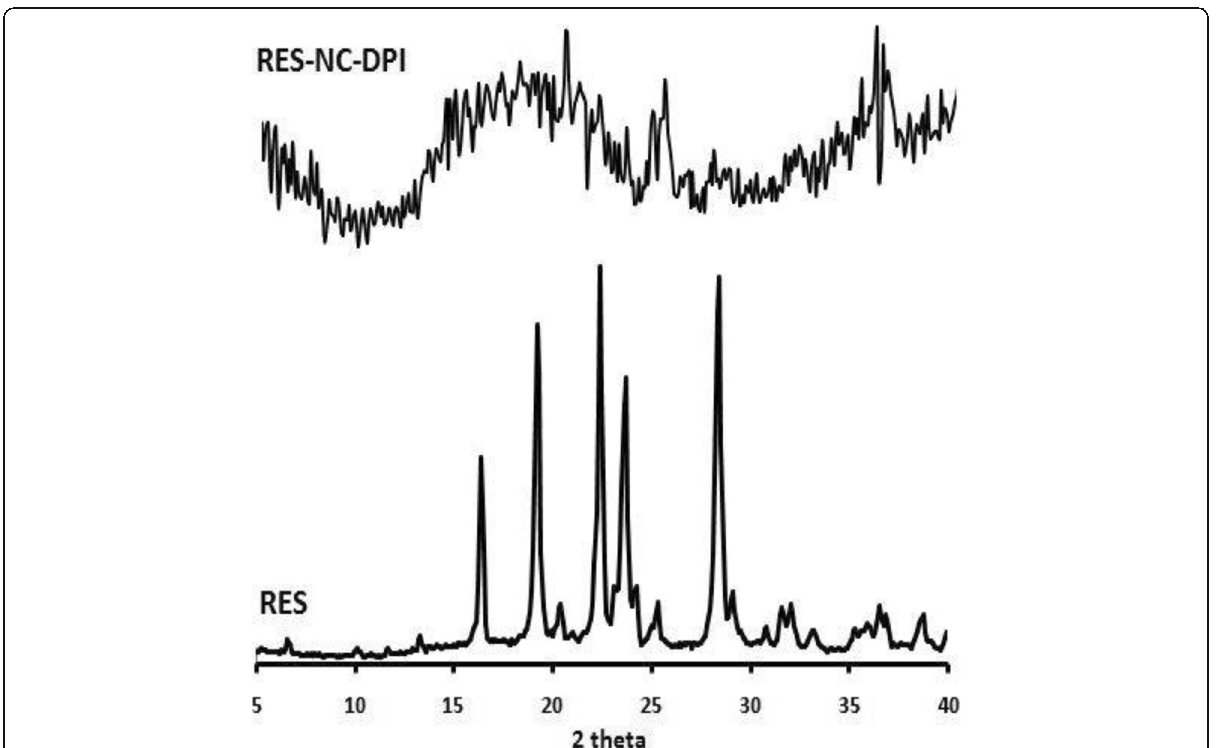
Fig. 2 Powder X-ray diffraction of RES and